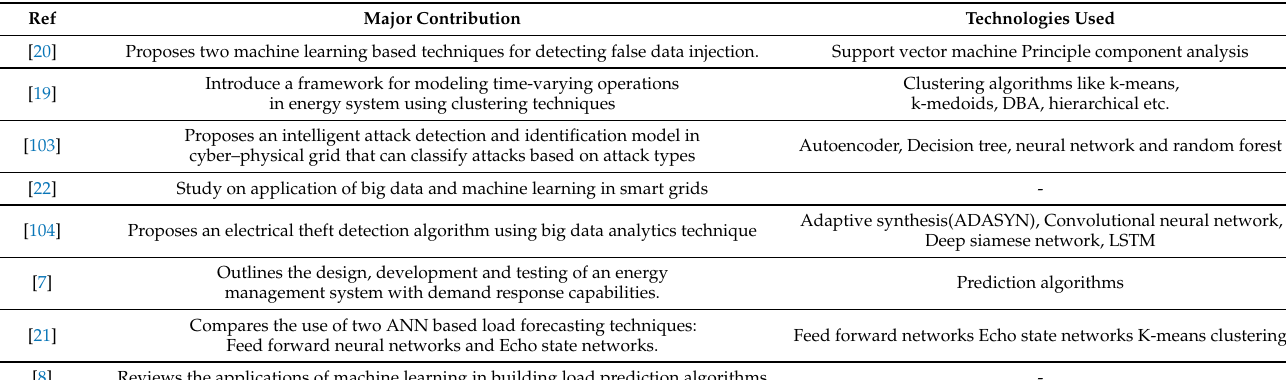
Table 8. Summary of existing works related to machine learning and smart